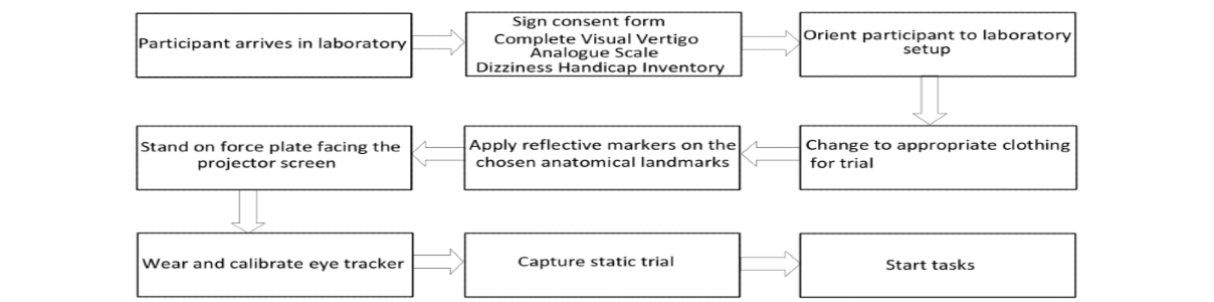
Figure 5. Data collection